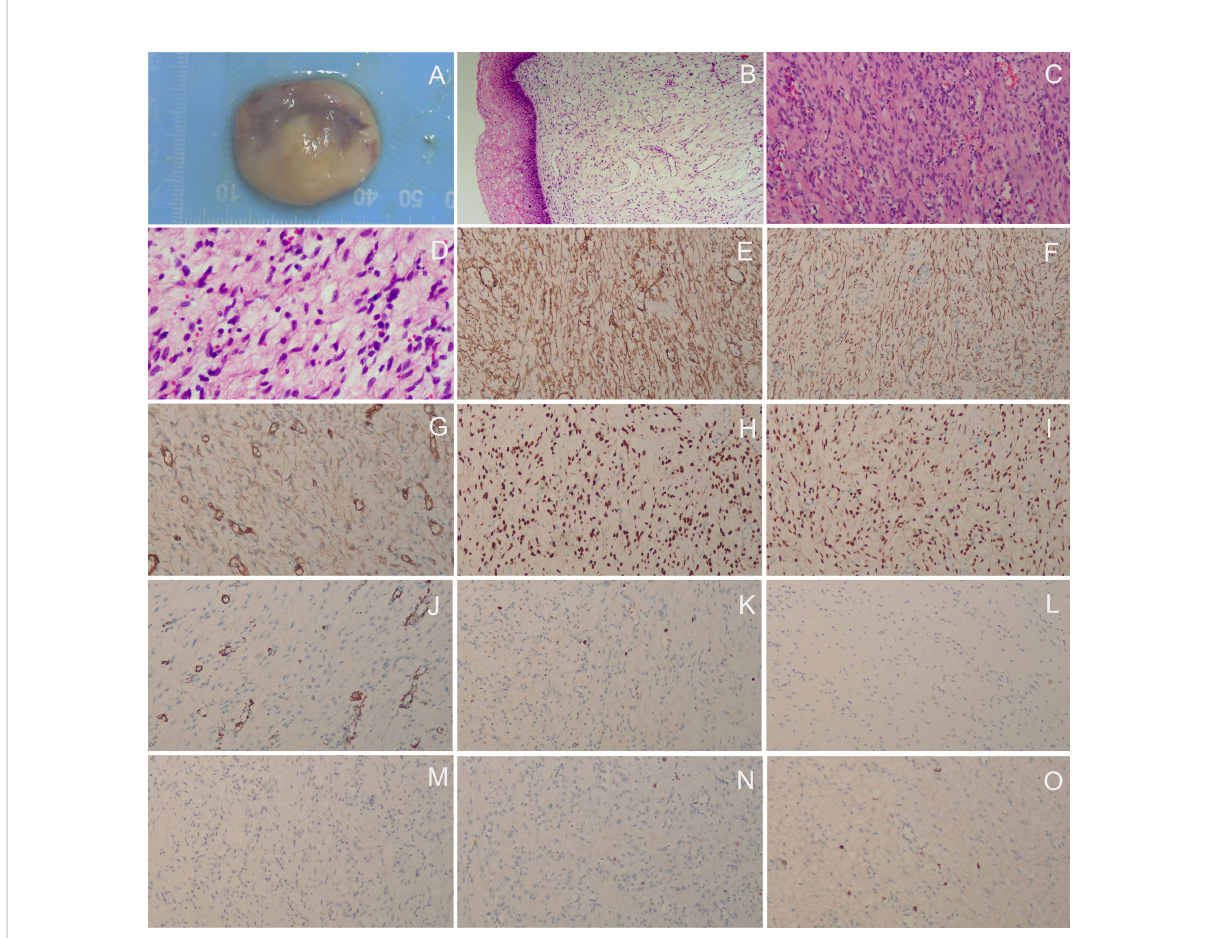
FIGURE 3 Histopathological and immunohistochemical staining fi ndings. (A) The gross pathological examination showed that the size of the tumor was approximately 3.2 cm × 2.8 cm × 0.8 cm, the texture was tough and slightly soft, and the color was pink white; (B) The tumor tissue was located under the squamous epithelium (H&E staining, ×40); (C, D) The tumor tissue was composed of spindle and stellate-shaped cells and contained abundant thin-walled blood vessels, with some mast cells scattered in the tissue (H&E staining, C, ×100; D, × 200); (E) caldesmon (+), (F) desmin (+), (G) CD34 (+), (H) ER (+), (I) PR (+), (J) a SMA (focally +), (K) Ki-67 (approximately 3% +), (L) CK ( – ), (M) EMA ( – ), (N) S-100 ( – ); (O) The scattered mast cells were positive for CD117 ( E-O ,